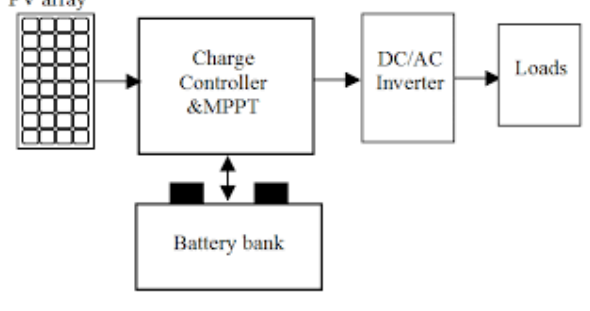
Figure 1. Stand-alone PV system.